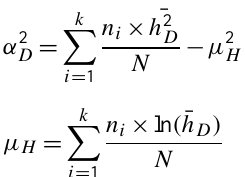
Fig. 4. Fragility curves developed for building typology “B”. D 1 to D 5 denotes the increasing damage level, from light damages to total collapse. Each point of the discrete set corresponds to the em- pirical cumulative frequency to have damage “ D ” in the flow-depth interval “ i ”.